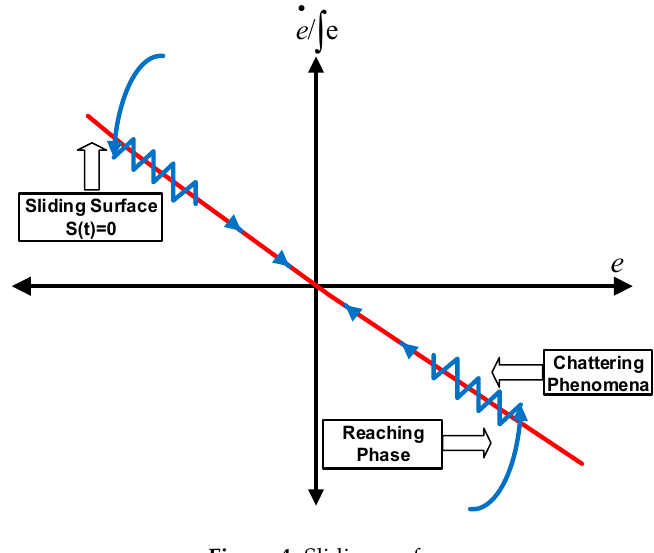
Figure 4. Sliding Figure 4. Sliding surface .